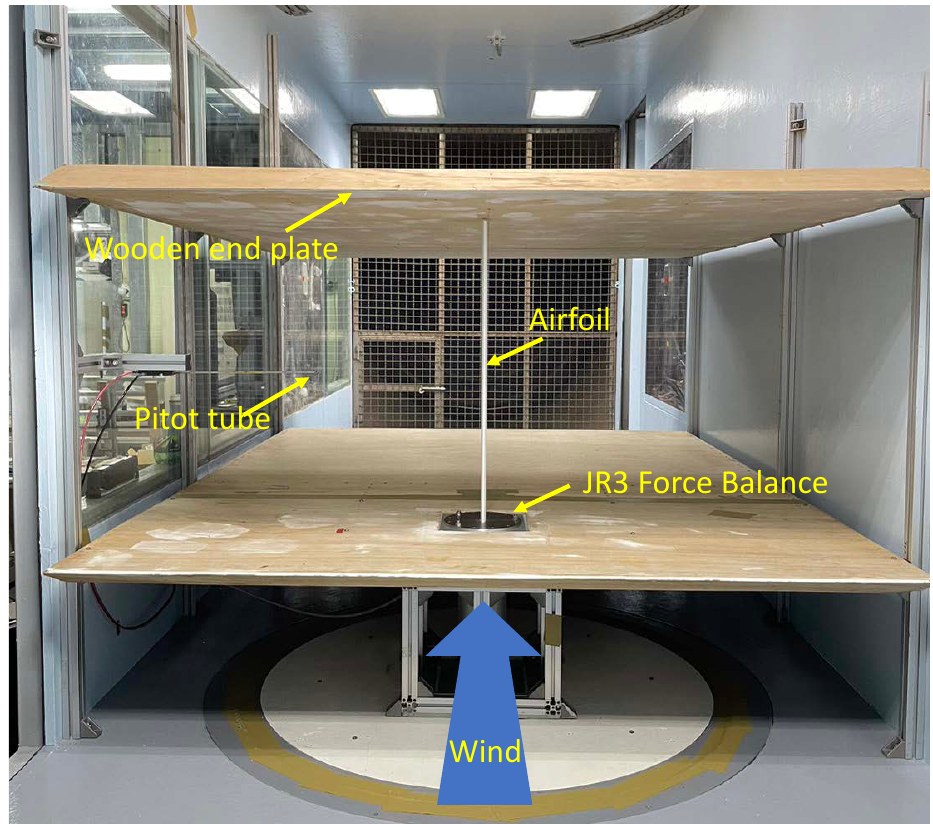
Figure 4. Wind tunnel test setup for the airfoil aerodynamic force measurements.